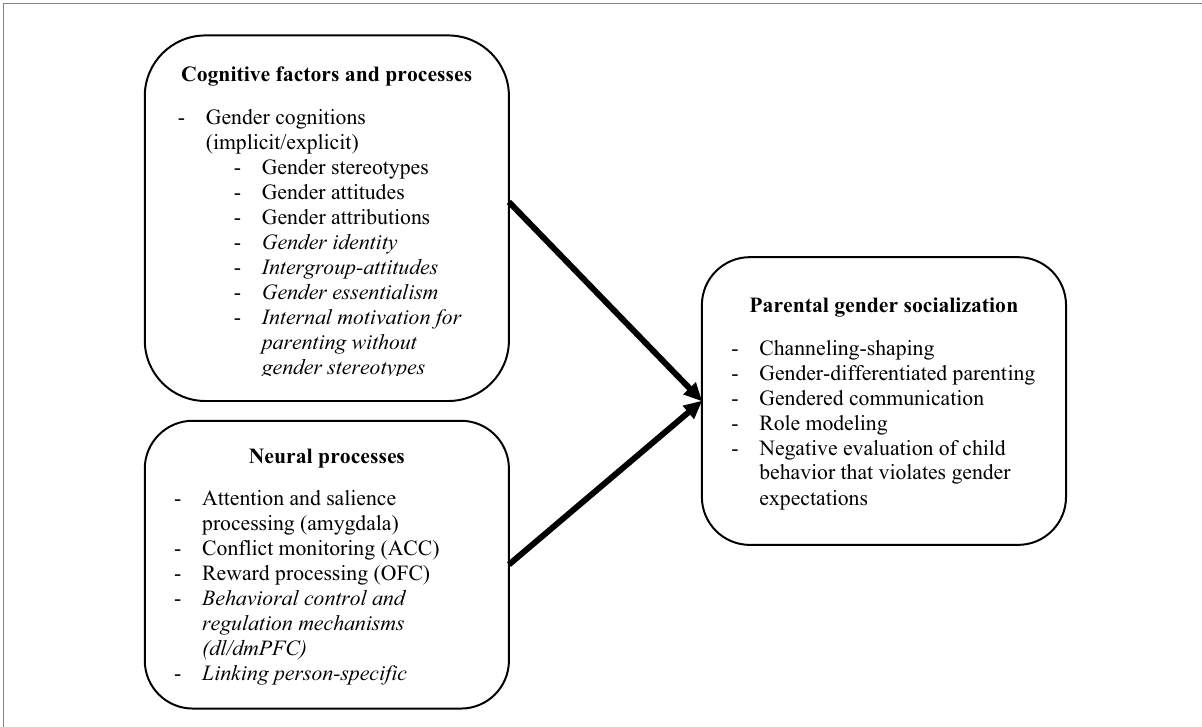
FIGURE 1 Overview of neural and cognitive processes underlying parental gender socialization. Cognitive and neural processes written in italics are processes for which there is only theoretical support and/or indirect empirical evidence linking these processes to other types of stereotyped behavior than gender socialization. For processes and factor that are not in italics, there is direct evidence of a link with parental gender socialization. The following abbreviations are used in the model: anterior cingulate cortex (ACC), dorsolateral and dorsomedial prefrontal cortex (dl/dmPFC), orbitofrontal cortex (OFC), anterior temporal pole